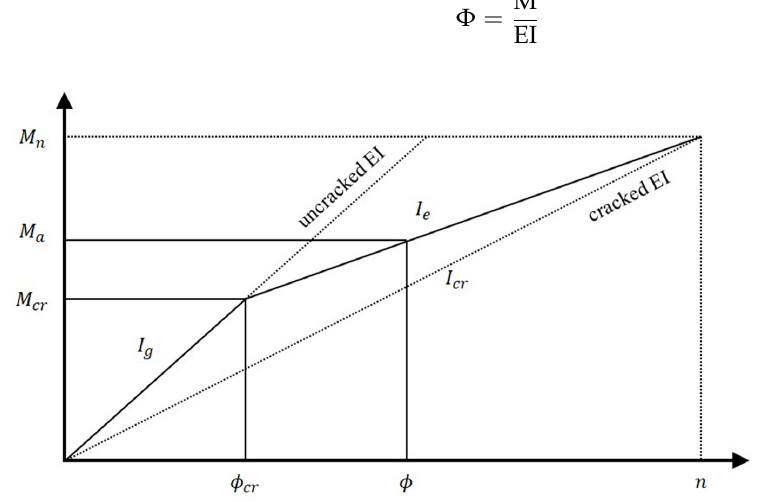
Figure 1. Bilinear moment–curvature relationship of an FRP-reinforced concrete section.